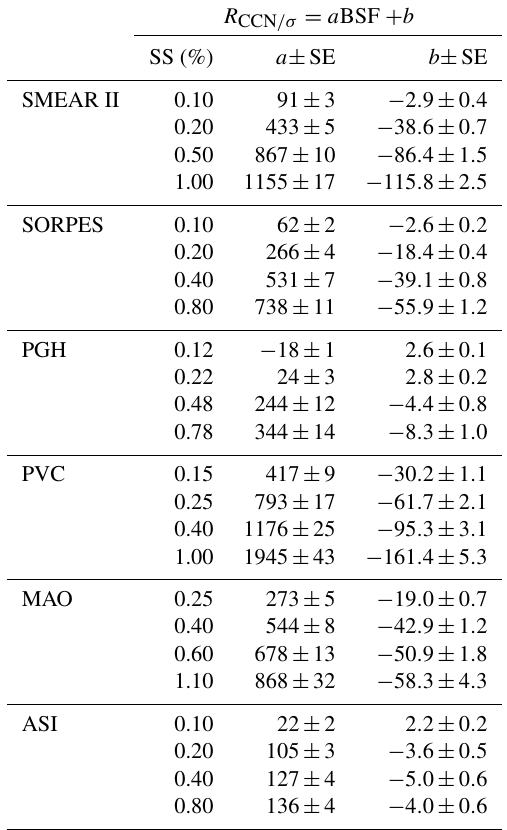
Table 3. The slopes and offsets of ordinary linear regressions of R CCN /σ vs. BSF at the different supersaturations (SS) at the studied sites. SE: standard error of the respective coefficient ob- tained from the linear regressions. The coefficients are written as [ N ] / [ σ sp ] = cm − 3 Mm. CCN